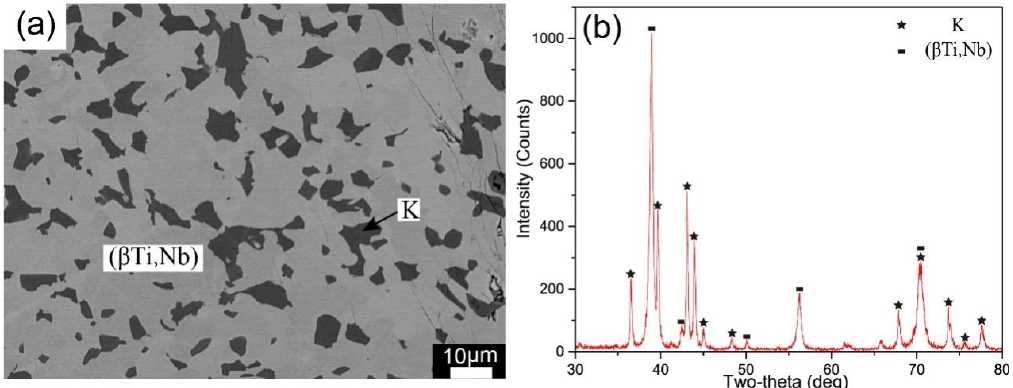
Figure 27. Alloy C6 annealed at 1373K for 40 days: ( a ) BSE images, ( b ) XRD patterns.